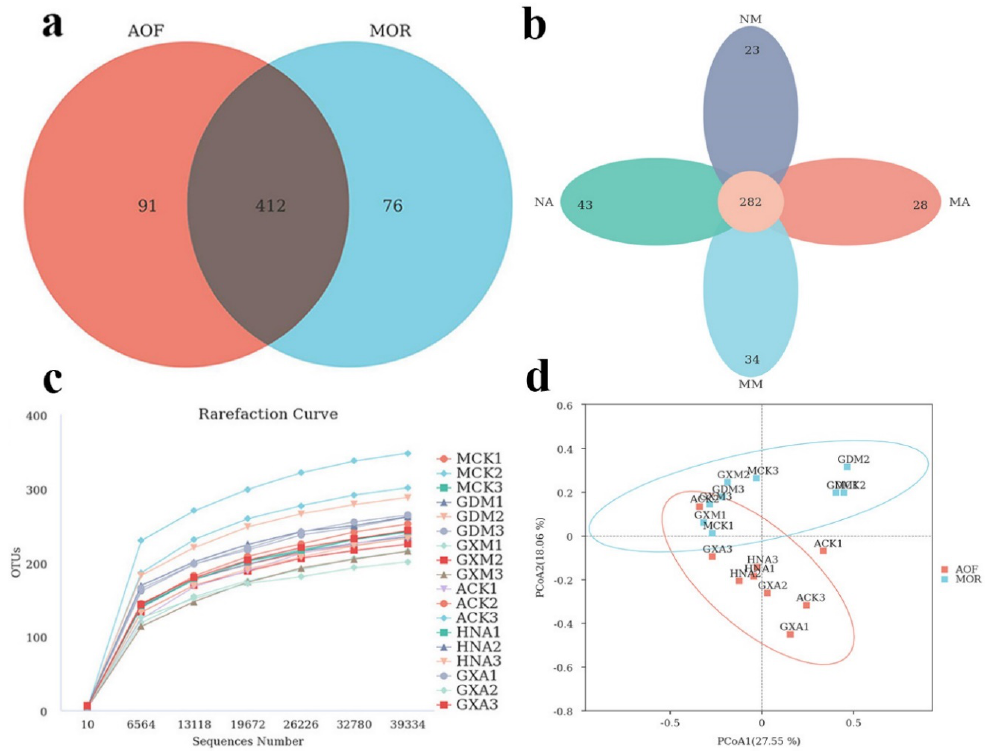
Figure 1. Analysis of fungal diversity in MOR and AOF samples. ( a ) Venn diagram of OTUs in the MOR and AOF groups; ( b ) Venn diagram of OTUs in the moldy and non-moldy samples; ( c ) Rarefaction curves for OTUs in all samples; and ( d ) PCoA diagram. of fungal compositions in samples.